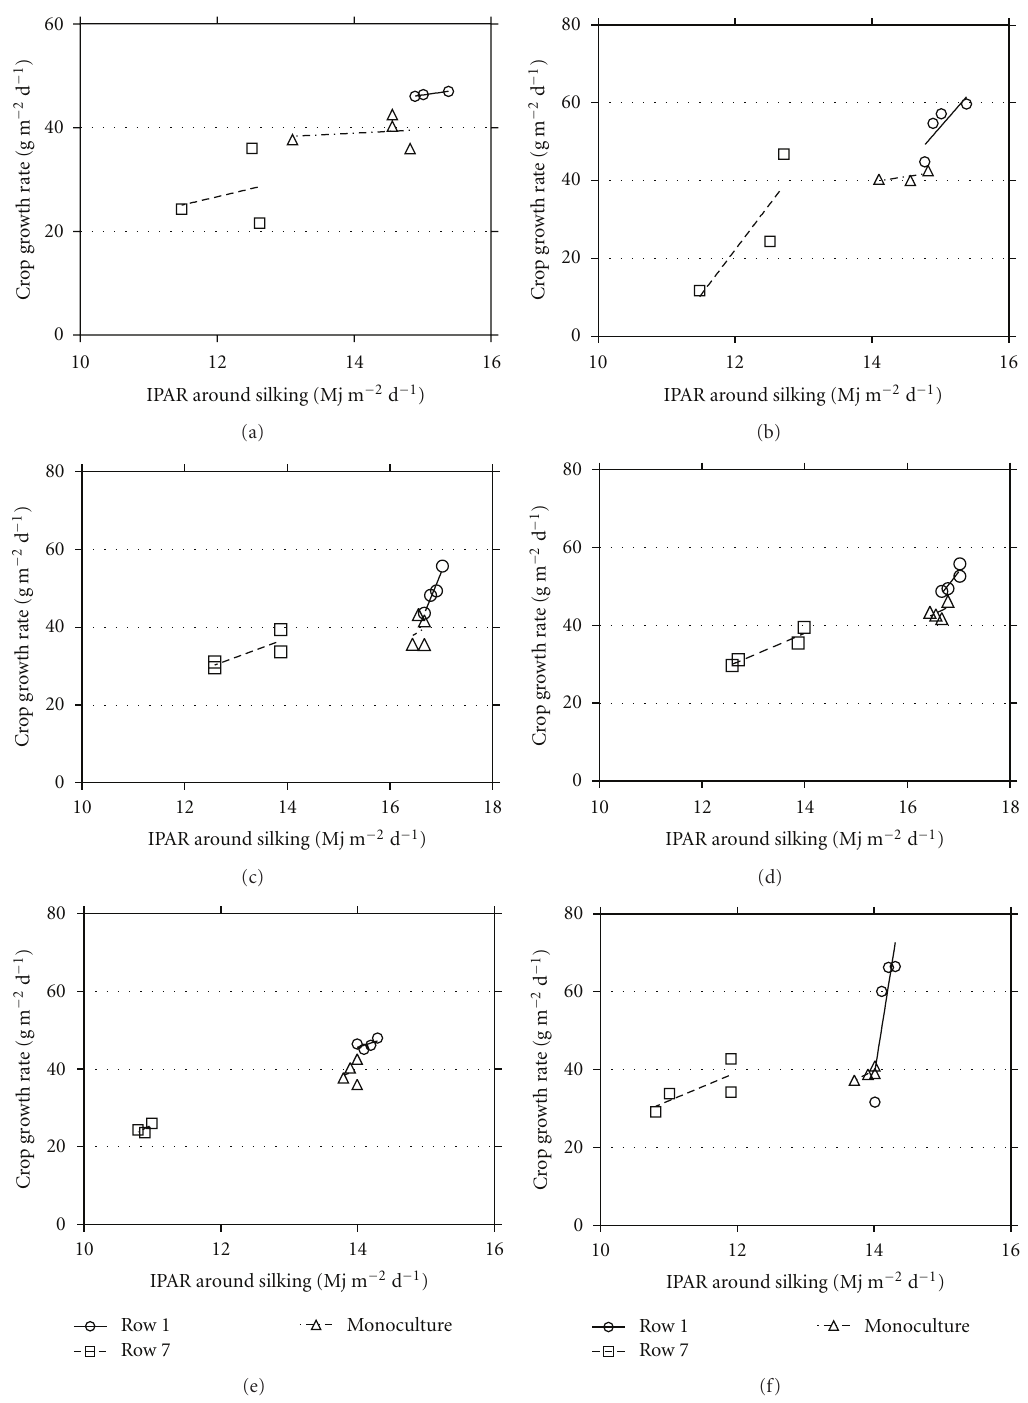
Figure 2: Corn growth rate around flowering related to IPAR in monocultures and in rows 1 (border) and 7 (center) in corn-soybeans MG III, during C1 (a), C2 (c), and C3 (e) and in corn-soybeans MG V, during C1 (b), C2 (d), and C3 (f).